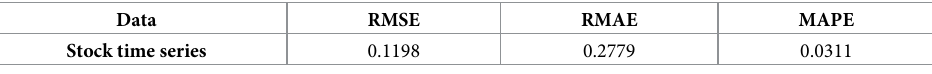
Table 4. Comparison of out-of-sample results for stock time series data using the ST-LSTM